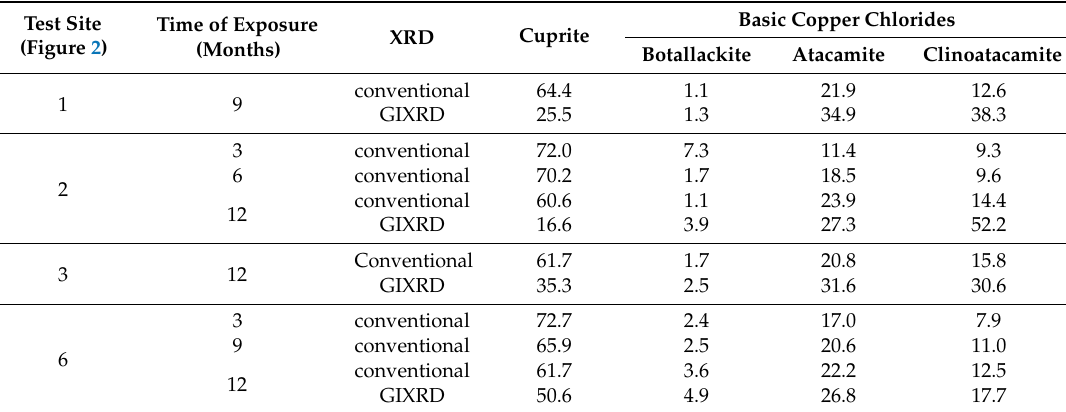
Table 4. Composition of the patinas formed on copper in coastal marine atmospheres in different exposure conditions. Data obtained by X-ray diffraction